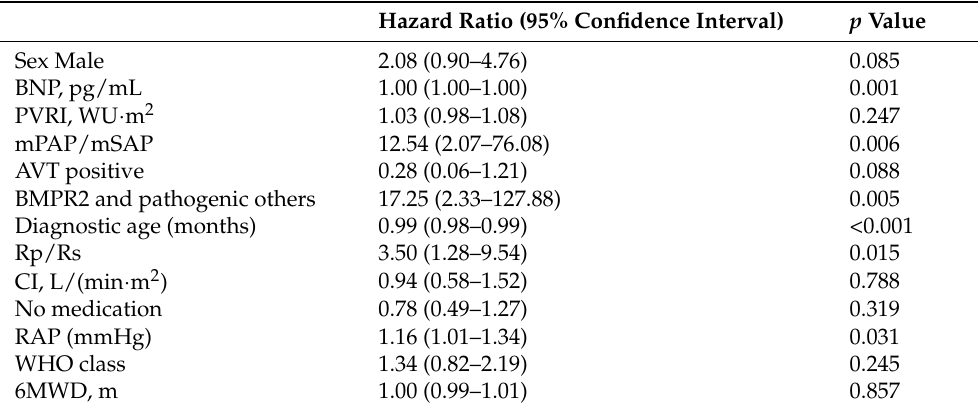
Table 2. Univariate Cox regression model for IPAH/HPAH risk of mortality.